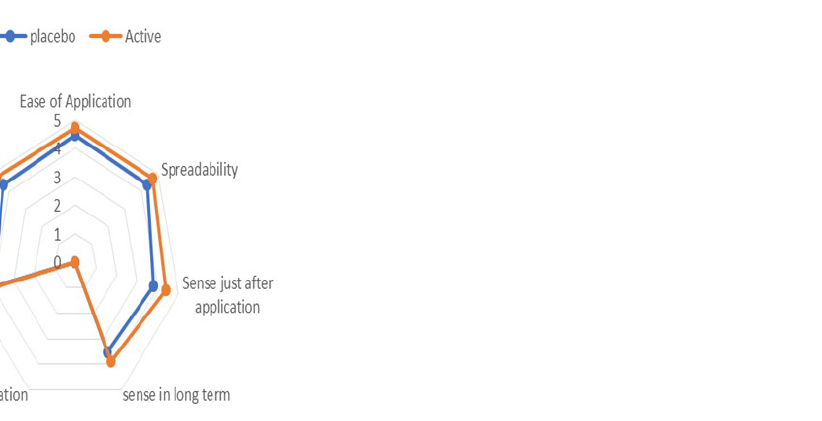
Figure 6. Panel test of placebo and active on human volunteers ( n = 13).